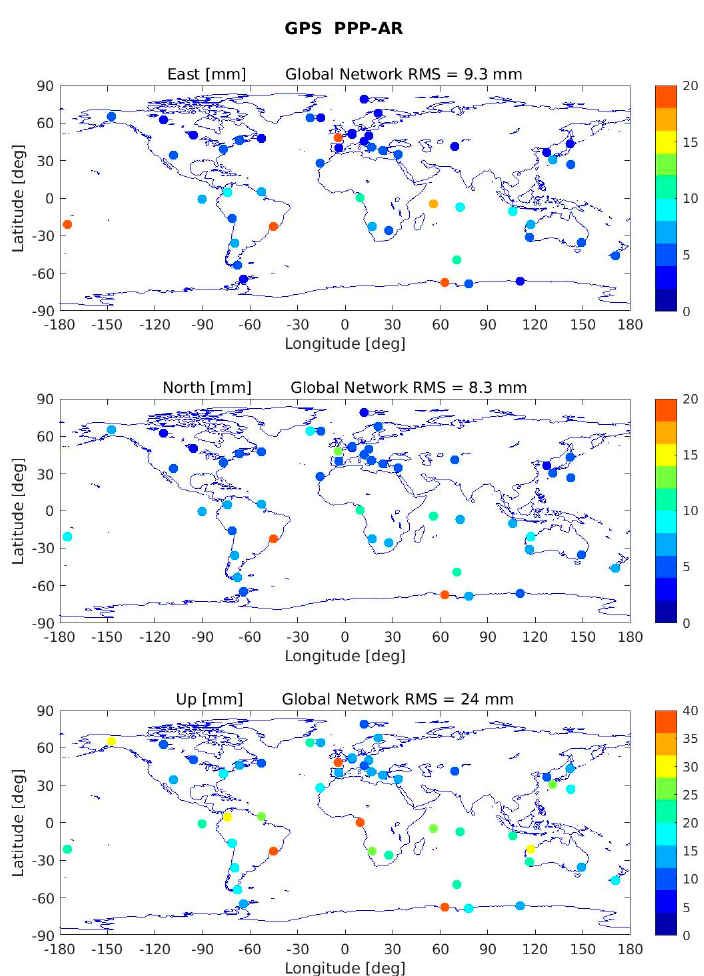
Figure 3. GPS PPP-AR solutions for the network of IGS stations in East, North and Up components and their global RMS (mm).